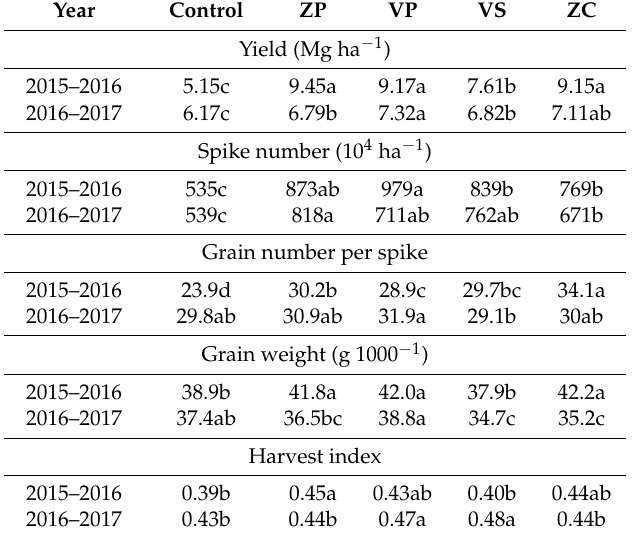
Table 2. Effects of the interaction between amendment treatments and year on wheat yield, yield components, and harvest index. ZP, zeolite + rock phosphate; VP, vermiculite + rock phosphate; VS, vermiculite + medical stone; ZC, zeolite + silica calcium soil conditioner. Year Control ZP VP VS